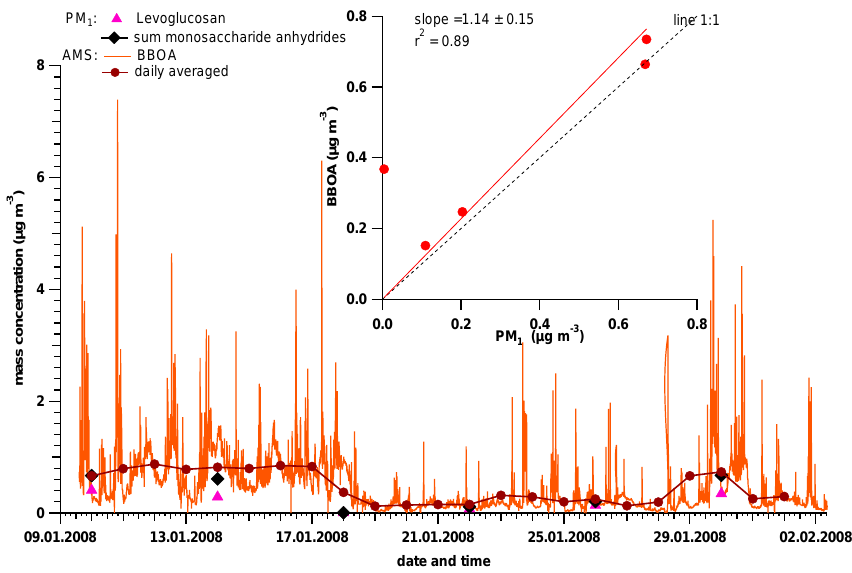
Fig. 4. Time series of BBOA factor and comparison with the sum of PM 1 MA identified (levoglucosan, arabitol, mannosan, mannitol, mannose, galactosan, glucose and